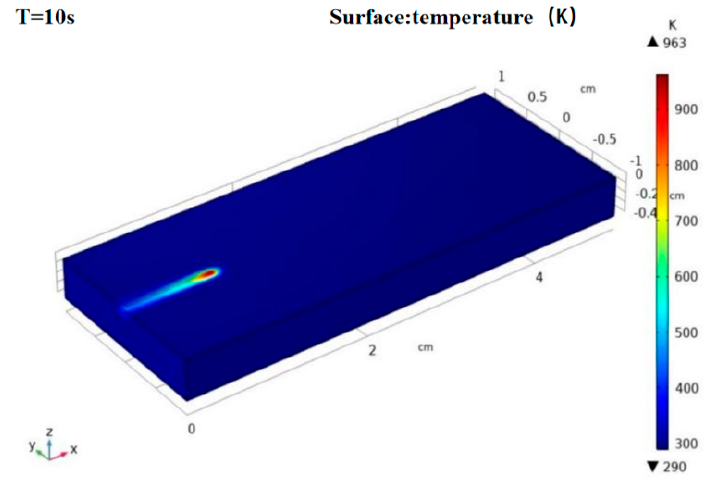
Figure 4. Surface temperature field distribution of PMMA under laser power of 4 W.